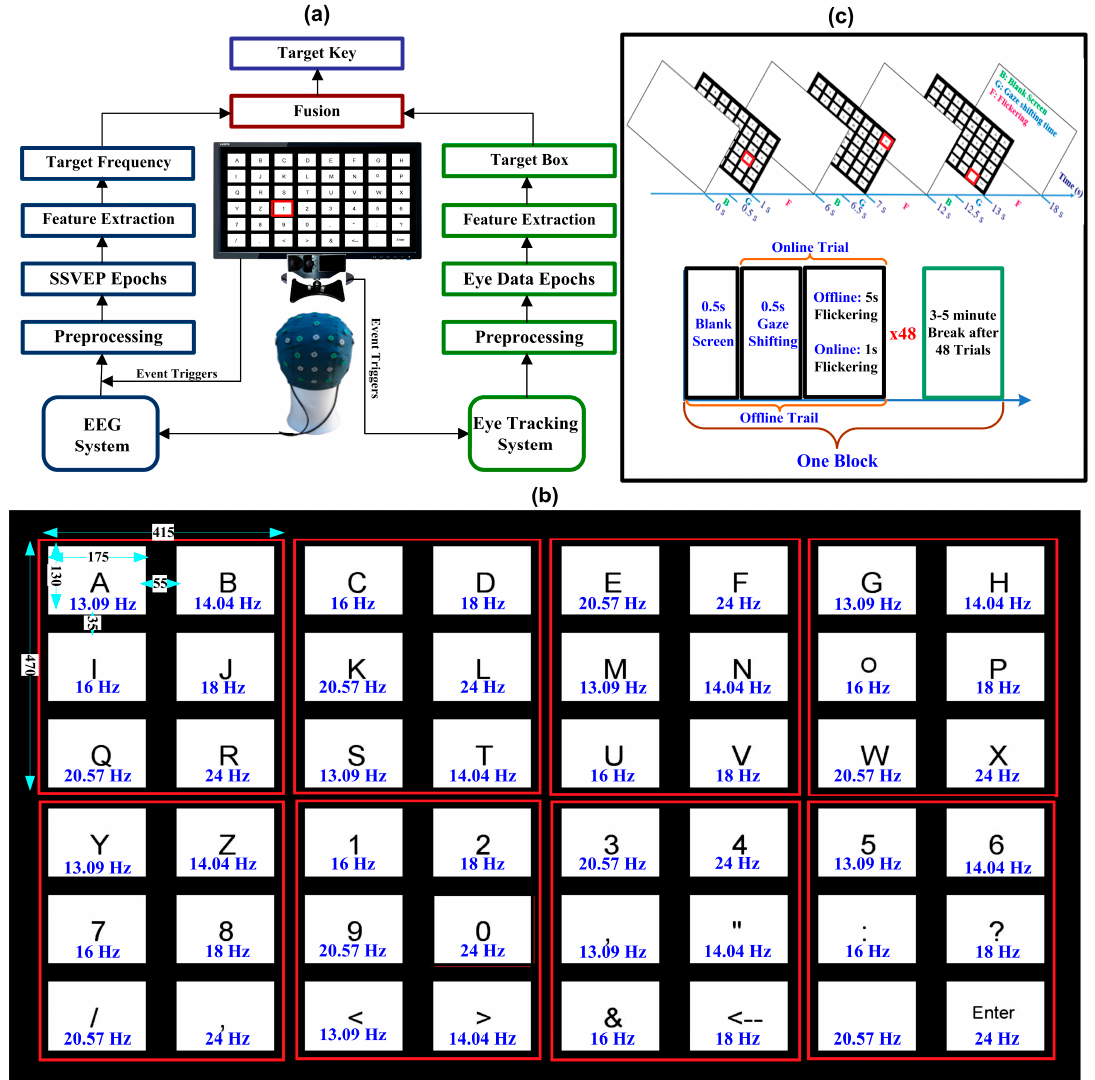
Figure 1. ( a ) Schematic diagram of the proposed framework. ( b ) Schematic diagram of the proposed speller with frequency of each target. Sizes were described in pixels. ( c ) Experimental paradigm.